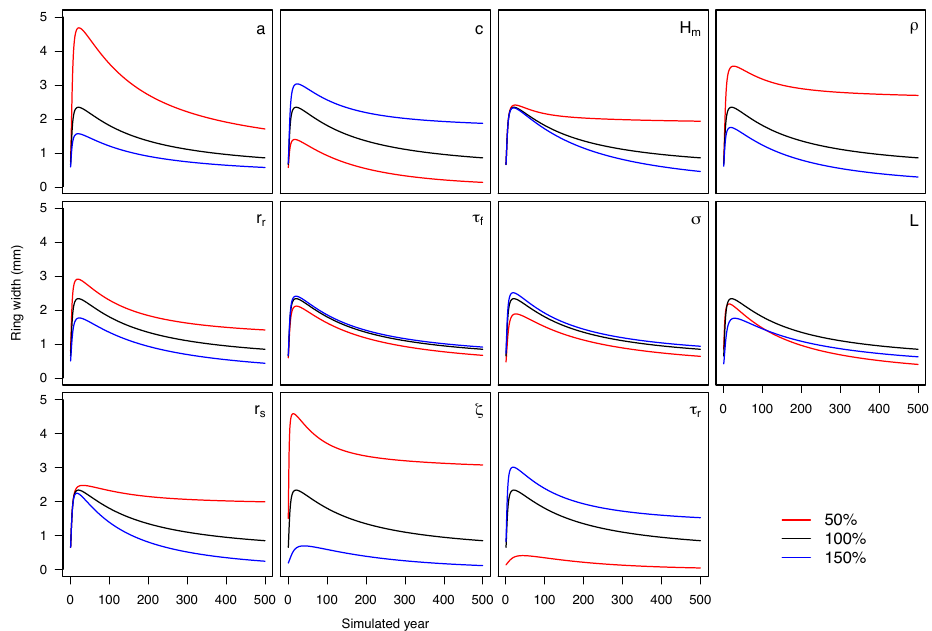
Figure 4. Parameter sensitivity analyses for the T model. A constant input of gross primary productivity (GPP) (mean during the period 1958–2006) was used to drive the T model to simulate tree growth for 500 years following establishment. The black line was obtained with the reference value of each parameter. The effects of an increase (150% of reference value; blue line) and a decrease (50% of reference value; red line) are also shown. Table 2. GLM analysis of tree-growth response to the climatic factors and age, based on simulations and observations. The dependent variable is mean ring width series (1958–2006) for each age cohort (young, mature, and old). The independent variables are the growing-season total annual photosynthetically active radiation (PAR 0 ), mean annual temperature (MAT), and the ratio of actual to potential evapotranspiration ( α ), with age cohort treated as a